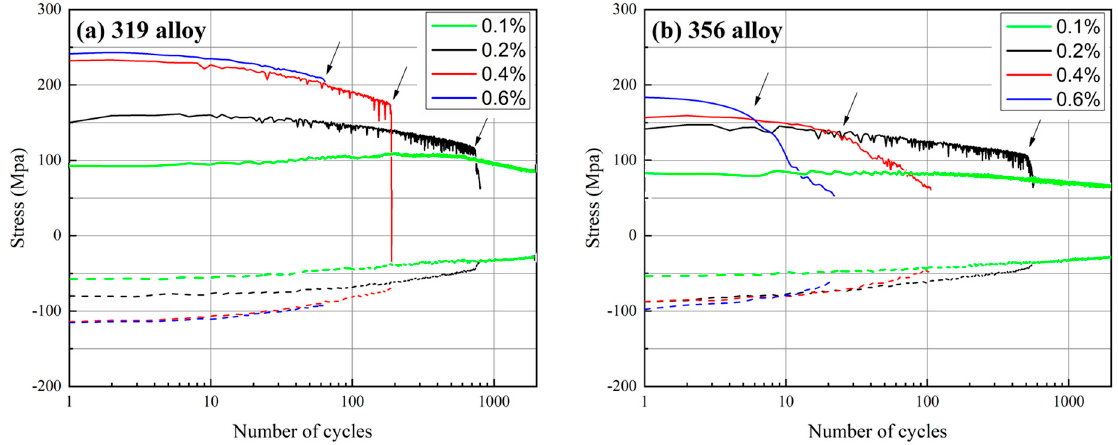
Figure 3. Evolution of the maximum tensile and compression stresses as a function of the cycle number at different strain amplitudes: ( a ) 319 alloy; ( b ) 356 alloy.